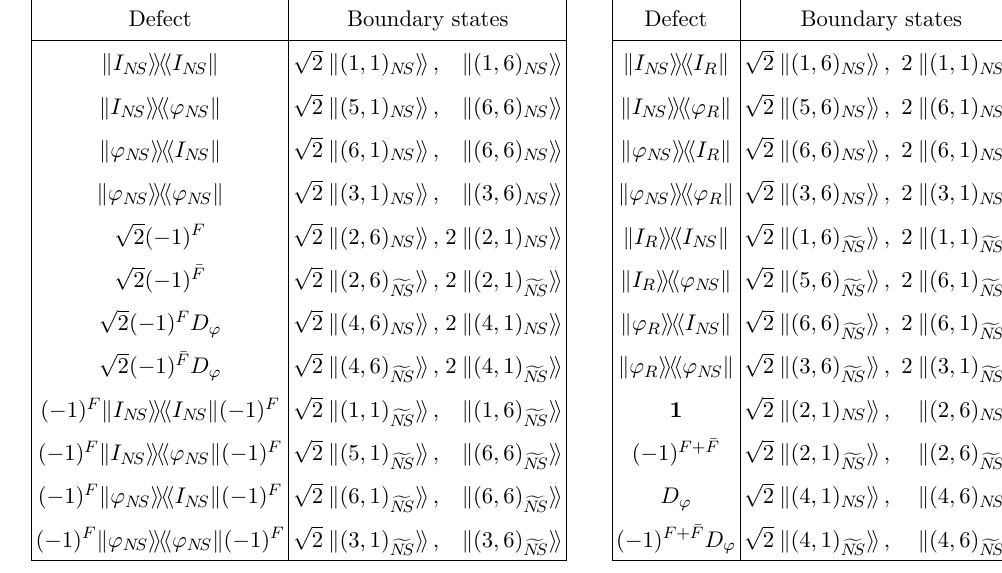
Table 4 . Identi(cid:12)cations of the boundary states corresponding to the known